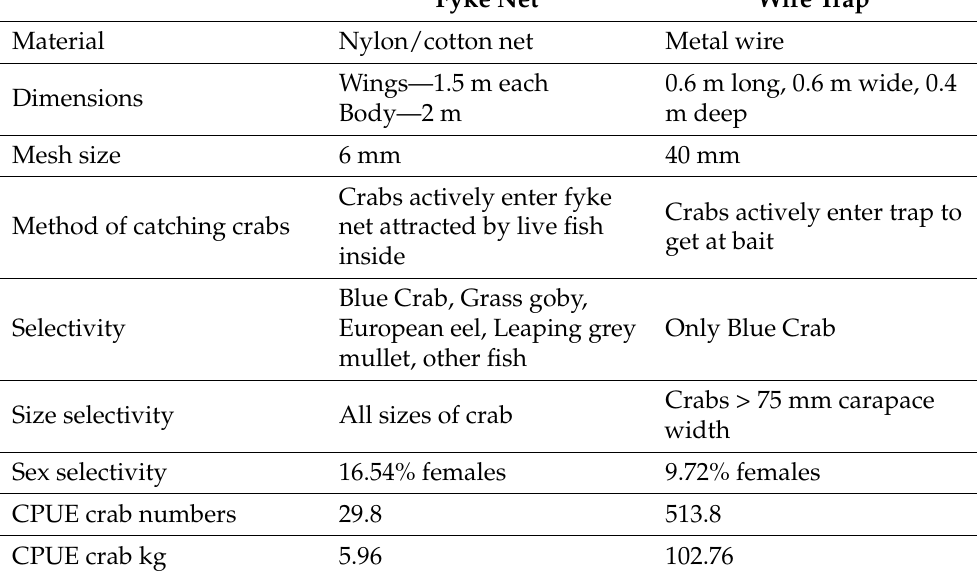
Table 2. A summary of the technical and fishery characteristics of the two types of